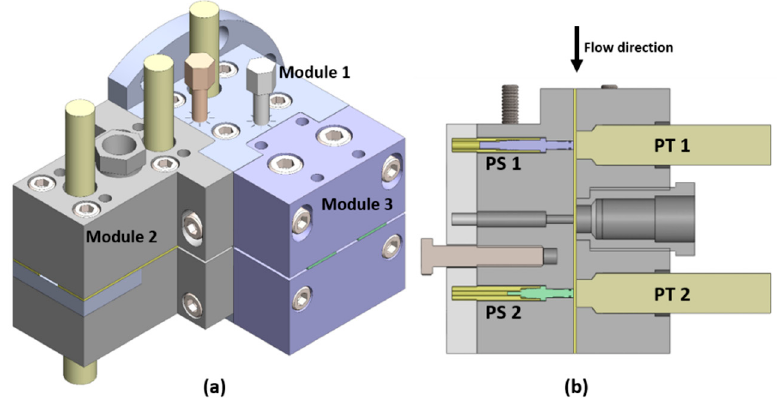
Figure 1. Schematic view of the double slit rheometrical die ( a ) and cross section view of the measurement channel (module 2) ( b ).